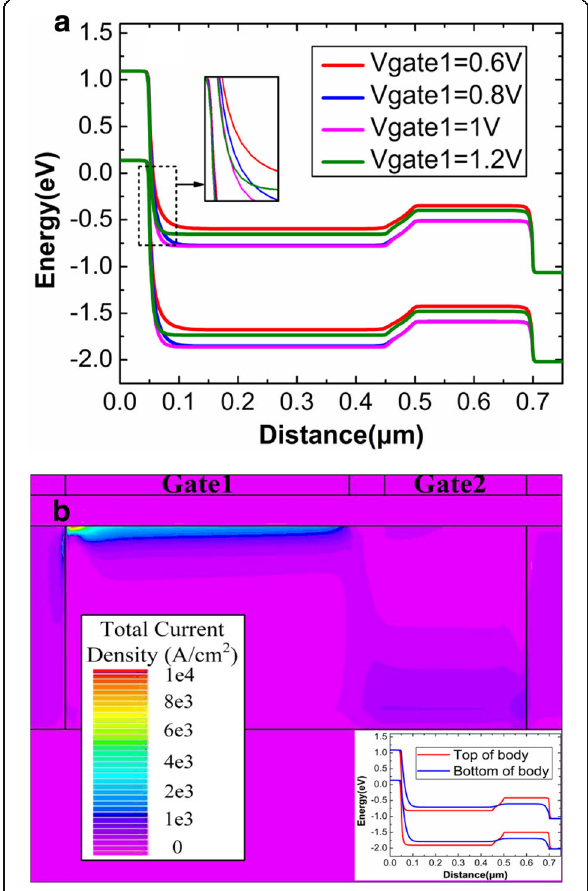
Fig. 8 a Energy band diagram and b total current density after reading “ 1 ” . a , b The energy band and total current density after reading “ 1 ” , respectively. The energy band is extracted at the 3 nm below the gate